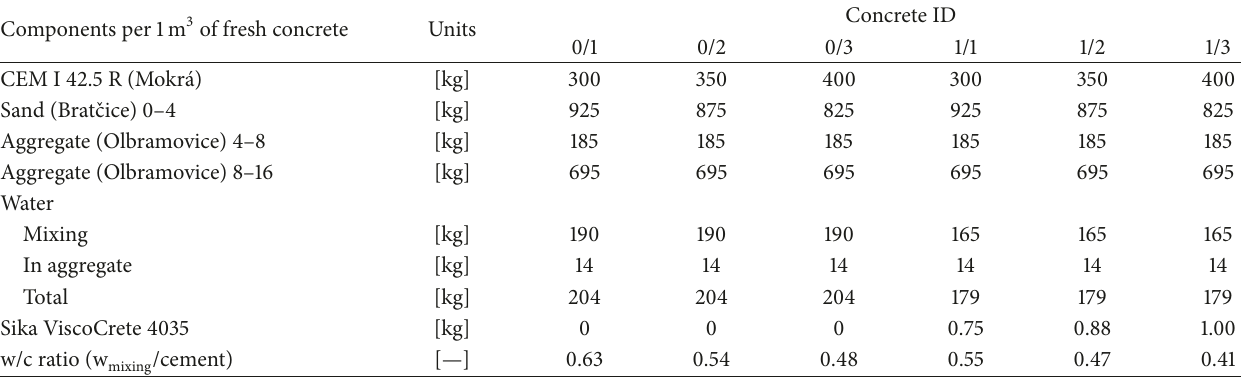
Table 2: Composition of fresh concretes.